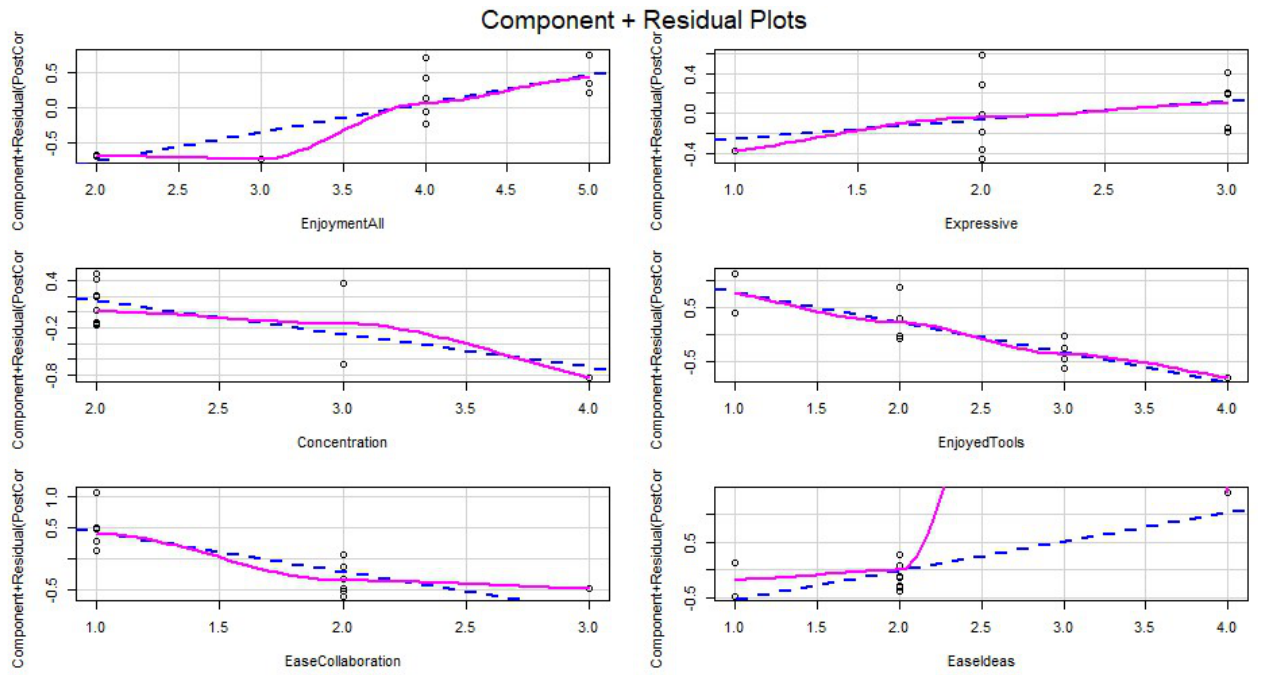
Figure 6. Linear regression component and residual plots.